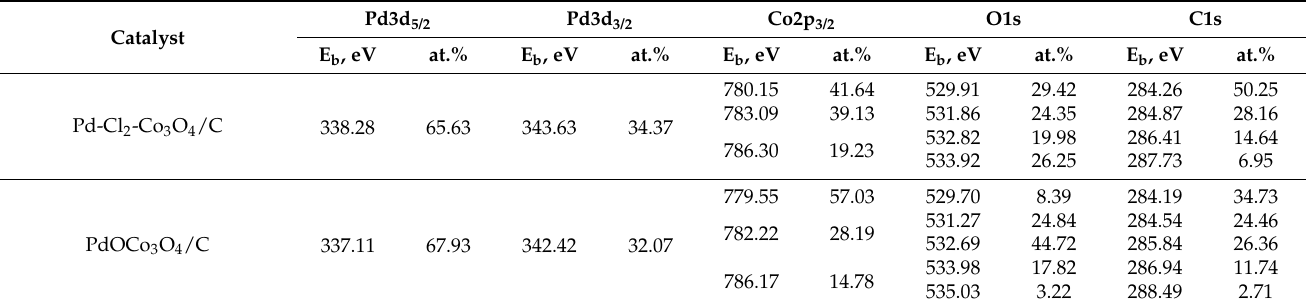
Table 3. Data from XPS analysis.